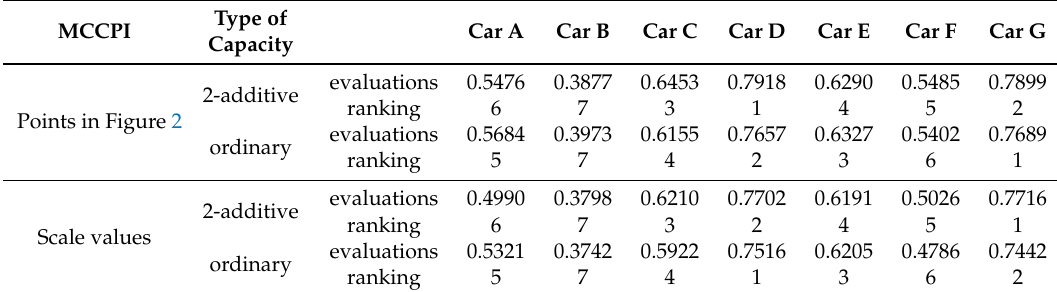
Table 5. The overall evaluations and ranking orders of the seven types of